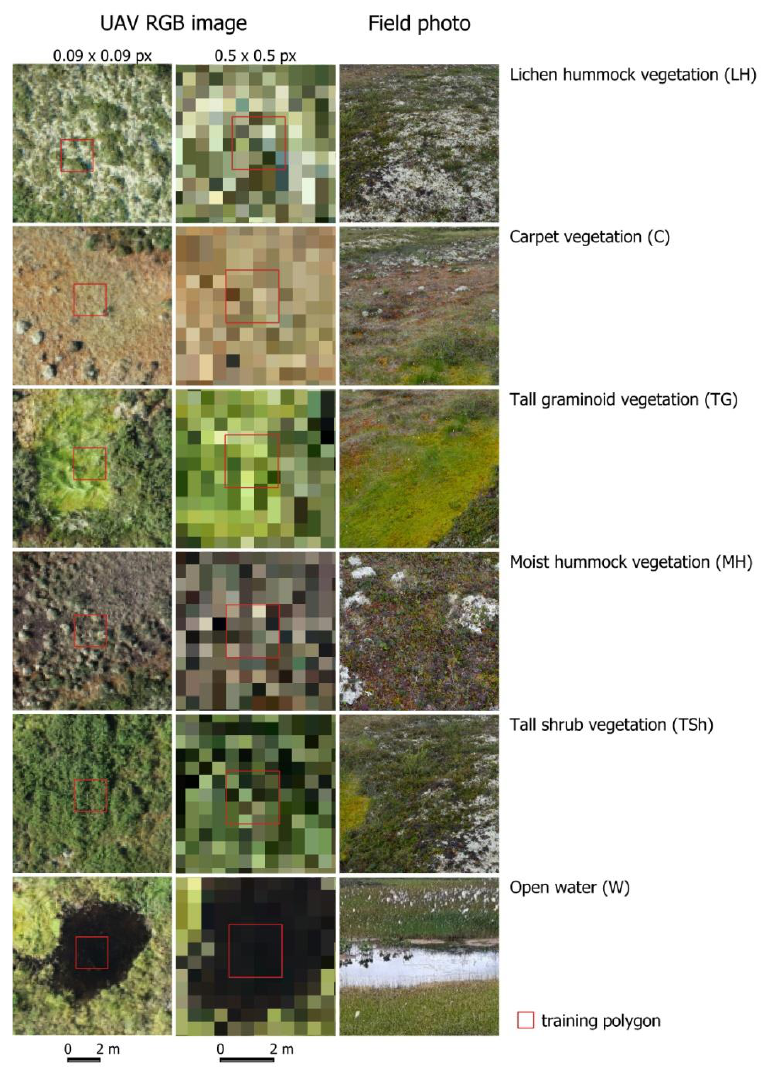
Figure 3. RGB imagery matrix for land cover classification in the surveyed site.